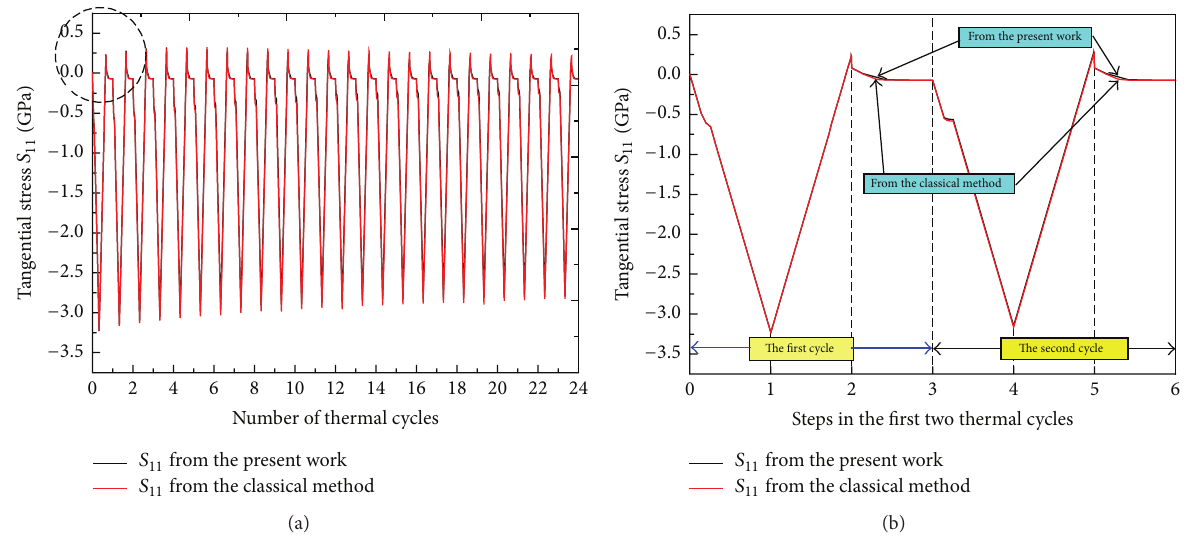
Figure 8: (a) The variation of the tangential stress ( 𝑆 11 ) at number 1 element at the base of the surface groove against the number of thermal cycles. (b) The details for the variation of tangential stress for the first two thermal